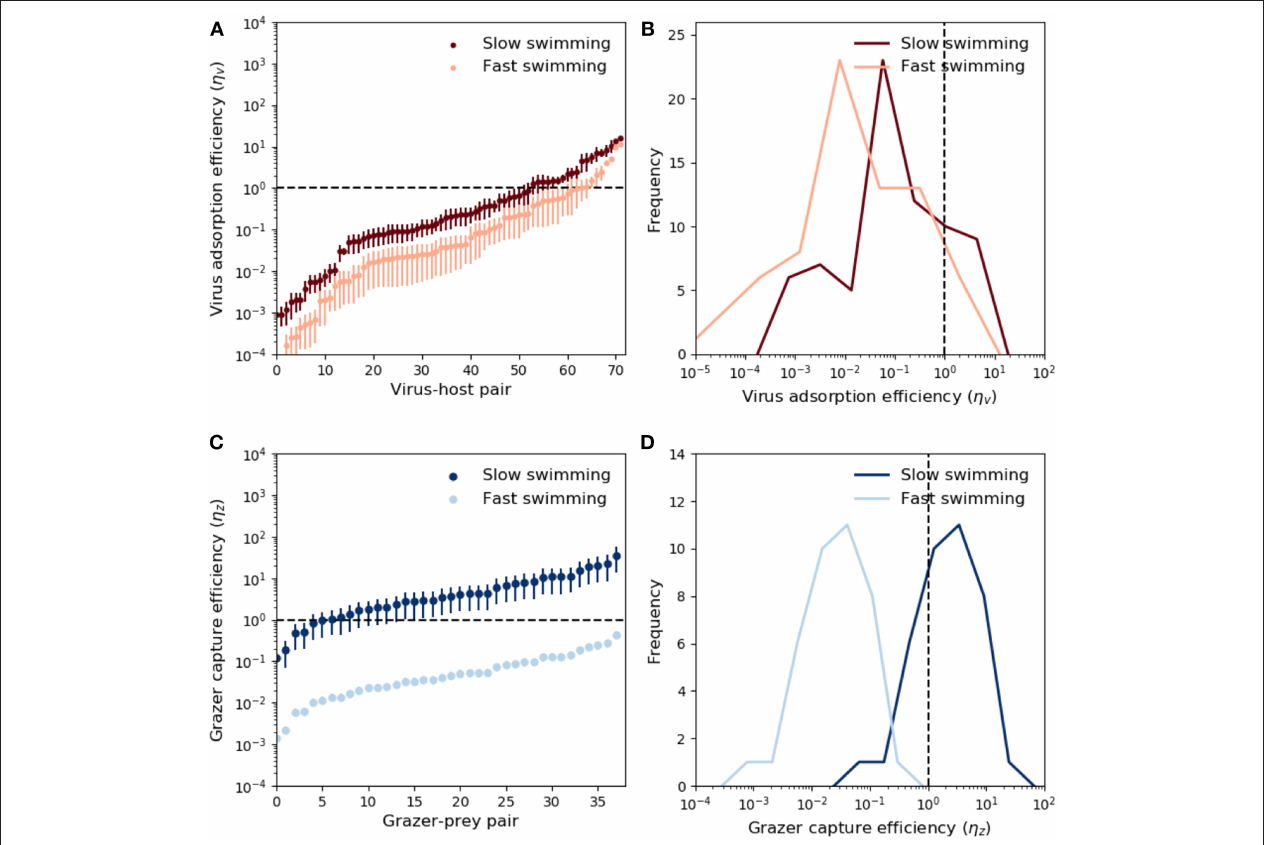
FIGURE 3 | Modeled virus and grazer capture efficiency. For viruses, these values are the measured mass specific adsorption rate, φ v , divided by theoretical predictions of mass-specific encounter kernel ( ρ v / Q v , Equation 5 and Table 2 ). For grazers, the capture efficiency is the mass specific maximal clearance rate, φ z , divided by mass specific encounter kernel ( ρ z / Q z , Equation 6 and Table 2 ). Predator and prey swimming speed and detection area were calculated with knowledge of predator-prey size, and the relations in Table 2 . (A) Adsorption efficiency for each virus-host pair. The horizontal dashed line marks the case of perfect adsorption, where the theoretical prediction of encounter kernel matches exactly the observed adsorption value ( φ d = ρ v / Q v ). Different shades show the sensitivity of these predictions to a range of scaling between body size and swimming speed (see main text). Whiskers correspond to uncertainty in measurements of virus and host size ( Supplementary Table 1 ). (B) Same data in (A) , expressed as histograms. (C) Capture efficiencies for each grazer-prey pair. Prey size was not specified, but whiskers indicate prediction uncertainty when predator:prey size ratios cover the full range reported in the data (Hansen et al., 1994, 1997). Different shades correspond to uncertainty in swimming speeds. (D) Same data in (C) , expressed as histograms.